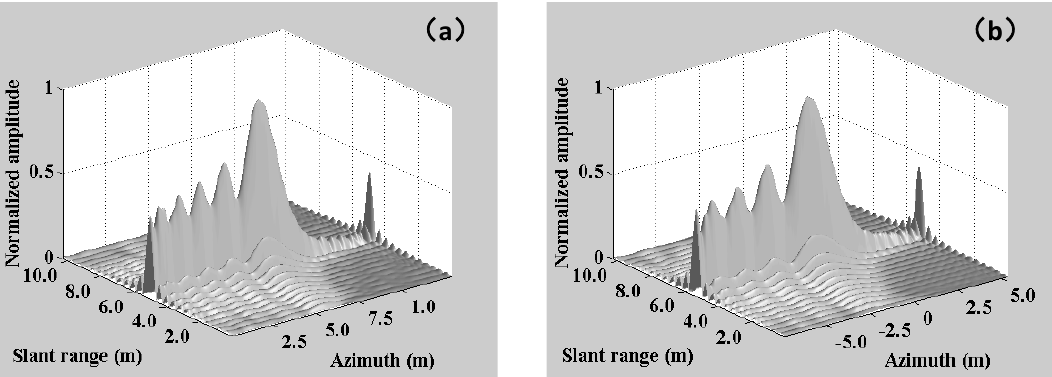
Figure 6. 3D response of the ( a ) center scatter and ( b ) edge scatter without motion error